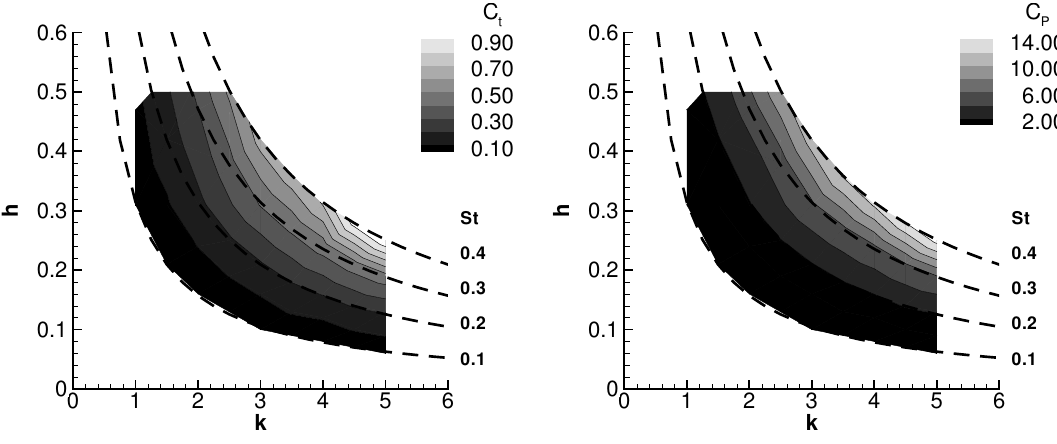
Figure 8. Mean thrust and power coefficients with Re =